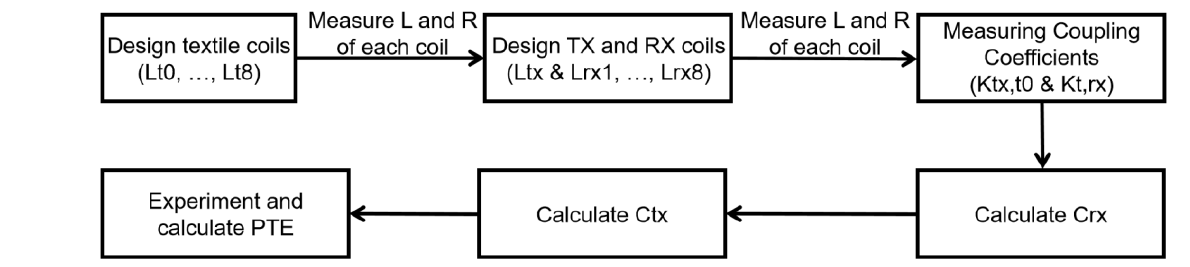
Figure 6. The designed circuit uses the CMCD.